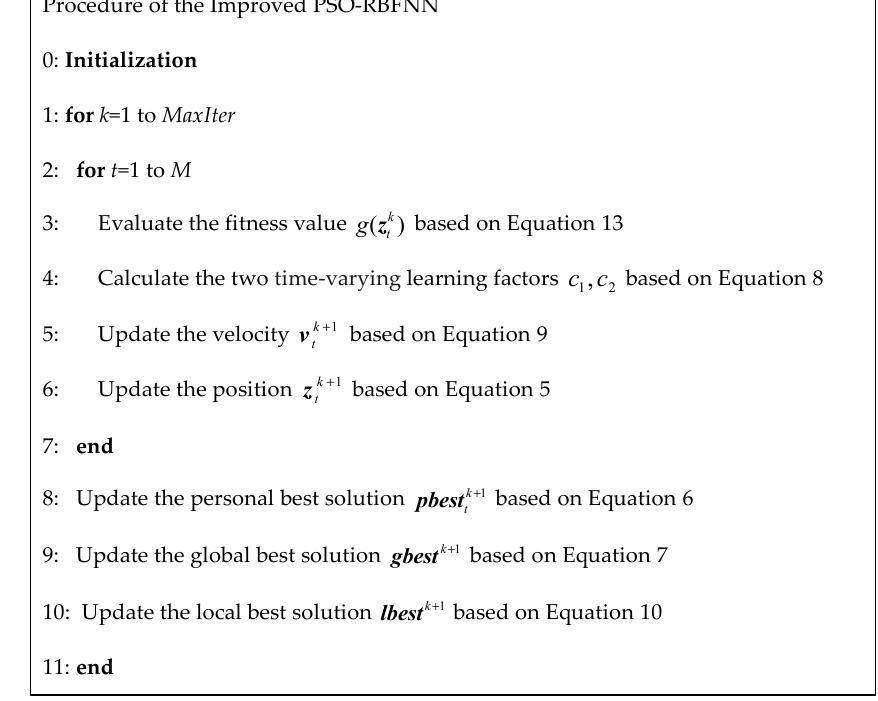
Figure 6. Improved PSO-RBFNN.